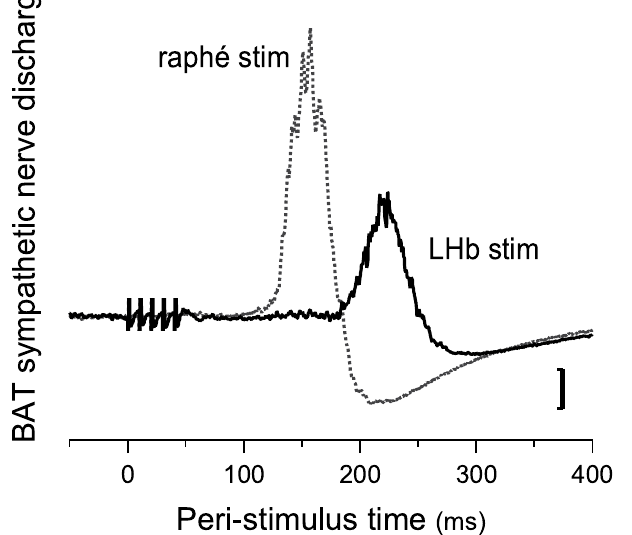
Figure 3. Peri-stimulus averaged potentials in BAT sympathetic nerve evoked by pulsed electrical stimulation of the LHb or the medullary